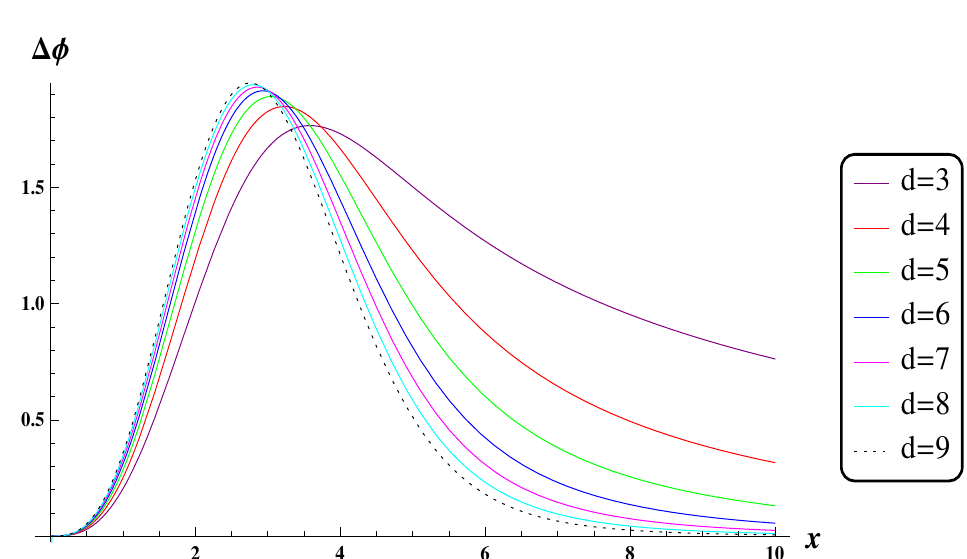
Figure 10. Gravitational deflection close to a non-commutative Schwarzschild black hole for η = 1.9 and α = 3.